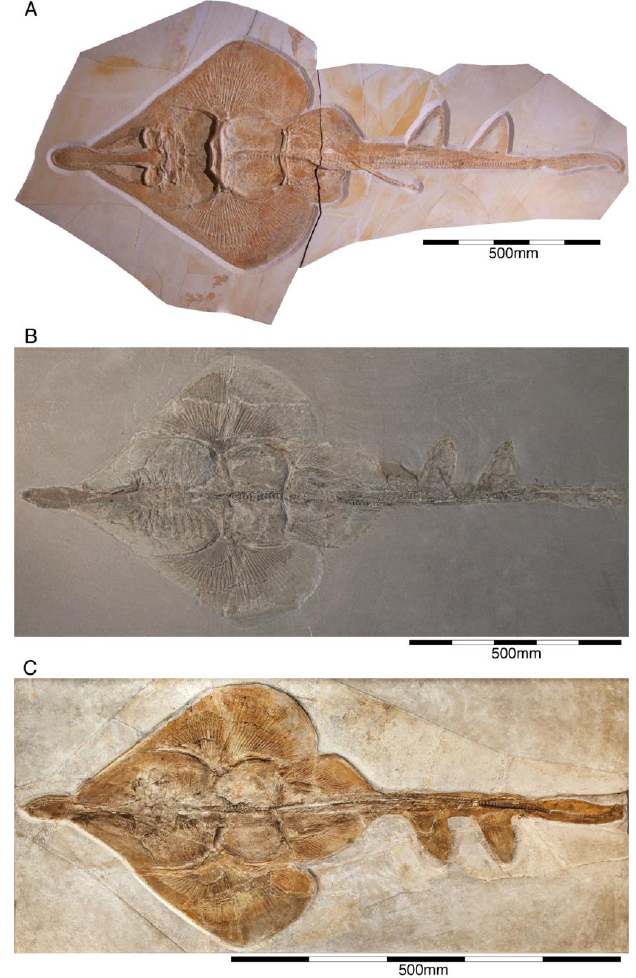
Figure 32. † Spathobatis bugesiacus Thiollière, 1852 [229]. ( A ) Holomorphic specimen (BMMS BK 3-1) from the lower Tithonian of Eichstätt. ( B ) Holomorphic specimen (SNSB-BSPG AS I 505) from the lower Tithonian of Eichstätt. ( C ) Holomorphic specimen (NHMUK PV-P-6010) from the Tithonian of Solnhofen. The teeth of † Spathobatis bugesiacus also resemble those of † Asterodermus platypterus to a high degree. They are wider than high and have a broad and well-developed lingual uvula and a mesiodistally running ridge through the low apex separating the crown ’ s labial and lingual faces. A distinct, peg-like apron is present, and the root is holaulacorhize [25]. However, † Spathobatis bugesiacus exhibits dental intraspecific variations, as teeth with a well-defined median cusp and a massive uvula are also known from this species [24,82,246,311]. This species also is known from holomorphic specimens in the Solnhofen Archipelago (see below). Isolated teeth of this species also were reported from the Kim- meridgian of England [246] and the Kimmeridgian of Switzerland [82]. A second species, † Spathobatis morinicus Sauvage [310], is known from a partially pre- served skeleton from the Tithonian of northern France [311]. Otherwise, all other species